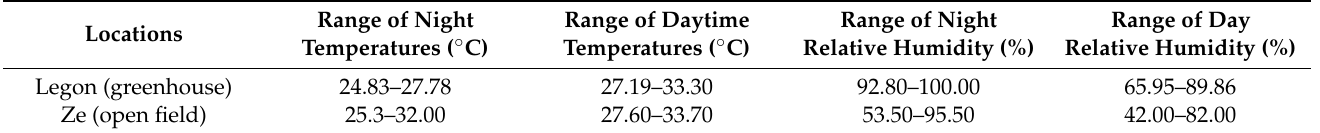
Table 2. Ranges of temperatures and relative humidities during the tomato